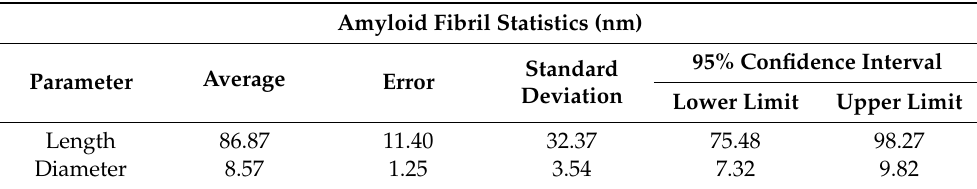
Table 1. Fibril measurement statistics based on a random sample of 31 of the amyloid fibrils from the TEM images. Data were collected using ImageJ